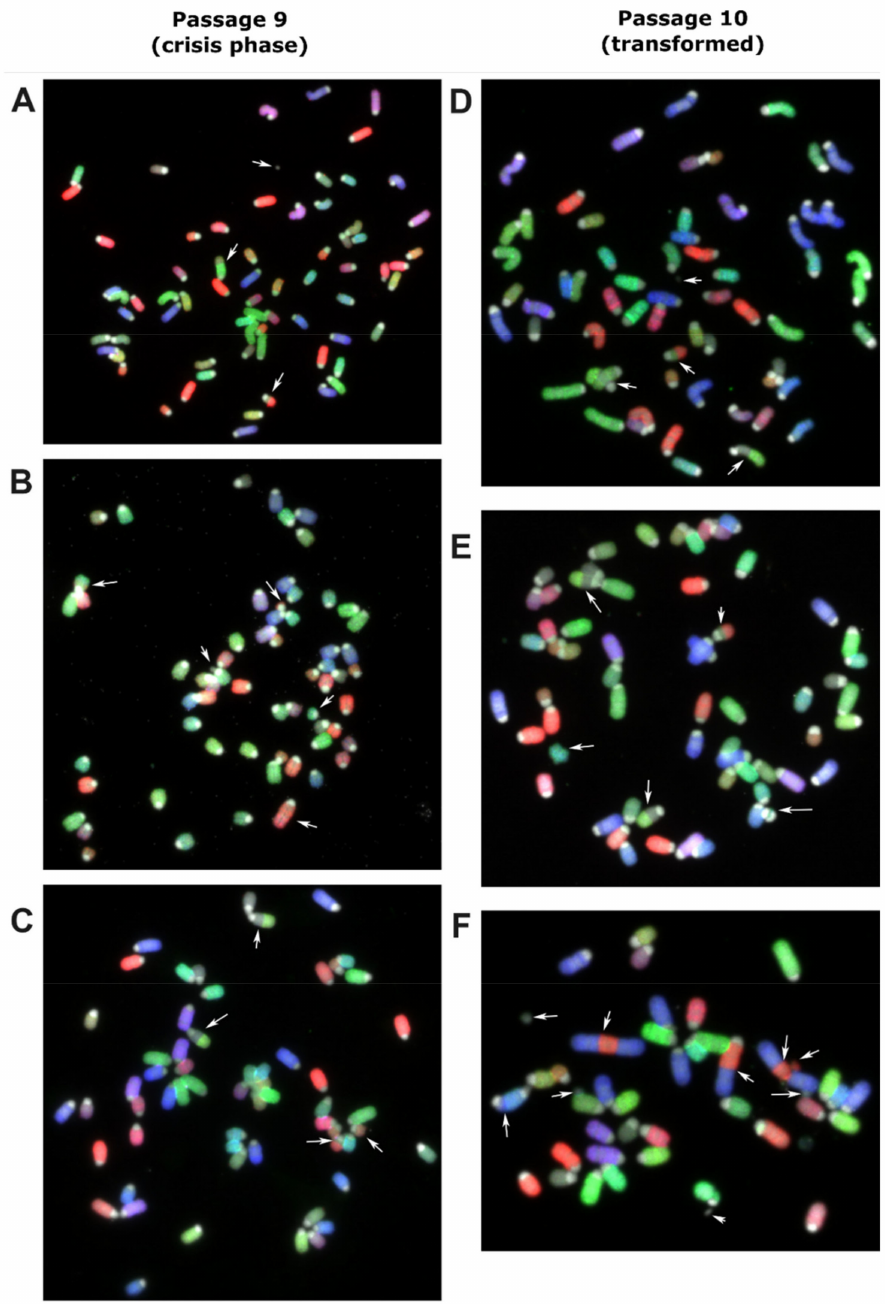
Figure 2. Murine MSC derived from bone marrow of a C57BL/6J mouse was harvested and molecular karyotyped at crisis phase at passage 9 ( A – C ) and the next passage (P10) after trans- formation ( D – F ) using COBRA-FISH. In all panels, both numerical and structural chromosomal alterations are visible. Arrows indicate involved chromosomes and rearranged chromosomes are listed per panel from top to bottom and from left to right: ( A ) Centromeric fragment, der(4)t(4;7), der(7)t(3;7), ( B ) der(16)t(13;16), del(3), centromeric fragment, del(13), der(3)t(3;12), ( C ) der(18)t(4;18), der(18)t(4;18), del(3), der(7)t(3;7), ( D ) centromeric fragment, der(7)t(3;7), der(18)t(4;18), der(18)t(4;18), ( E ) der(7)t(3;7), der(18)t(4;18), ace(17), der(18)t(4;18), dic(17;17), ( F ) centromeric fragment, acentric chromosome from chromosome 2-3-2 fusion, der(3)t(2;3), acentric chromosome from chromosome 2-3-2 fusion, fragment of chromosome 3, centromeric fragment, centromeric fragment, dic(5;11), centromeric fragment. COBRA-RGB-color images were superimposed with DAPI (grey) to visualize chromosome centromeric regions. Magnification 630 ×